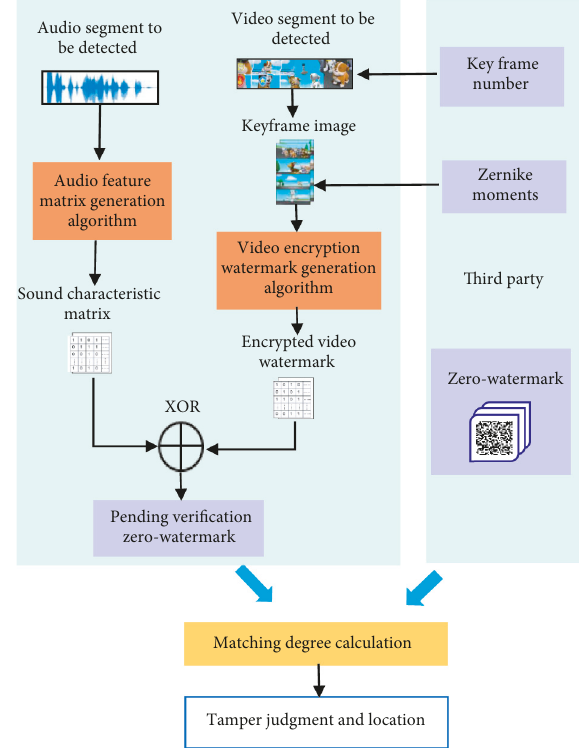
Figure 6: Audio and video matching detection and location process.